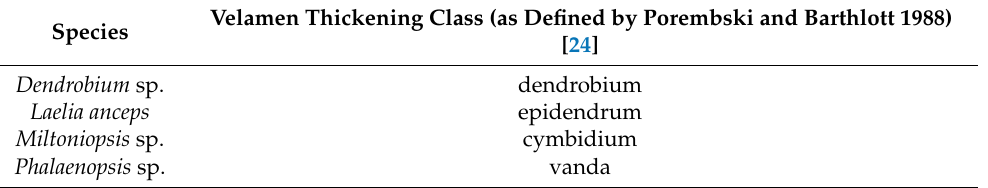
Table 1. Orchid species investigated. Velamen Thickening Class (as Defined by Porembski and Barthlott 1988) Species [24] Dendrobium sp. dendrobium Laelia anceps epidendrum Miltoniopsis sp. cymbidium Phalaenopsis sp.